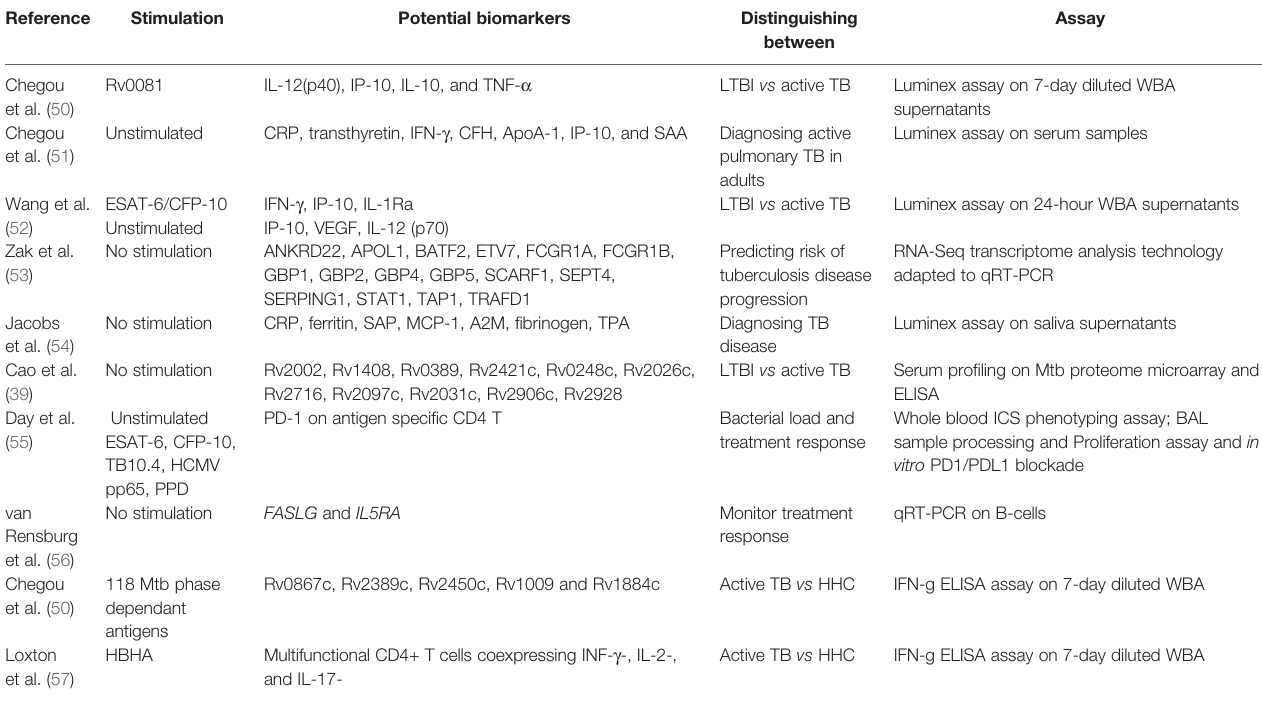
TABLE 1 | Potential biomarkers that can distinguish between different stages of M.tb